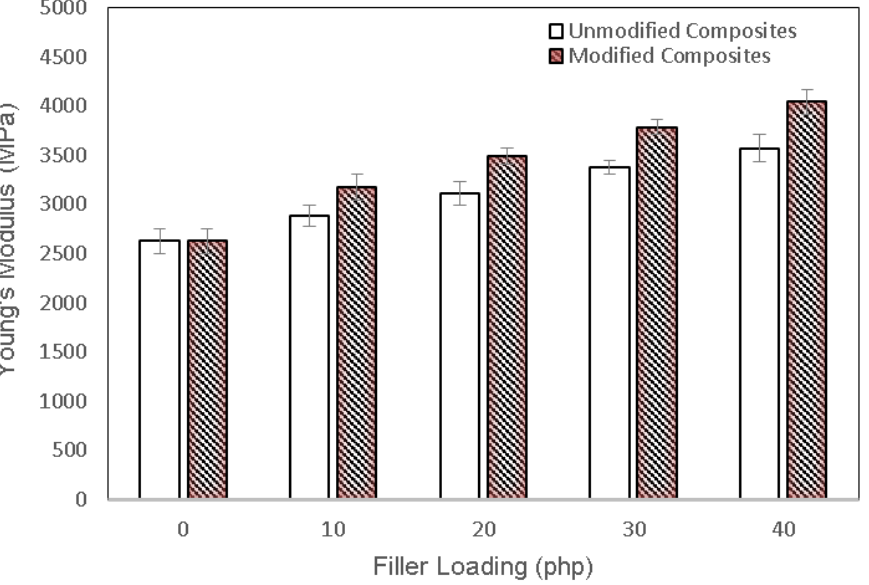
Figure 5. Young’s modulus of unmodified and modified PLA biocomposites at various chitosan content.